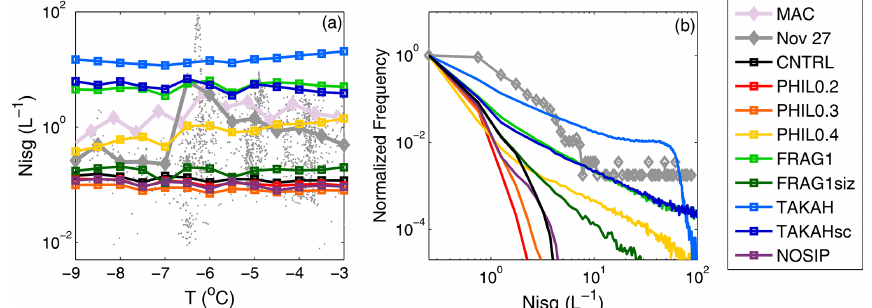
Figure 2. (a) Mean ice number concentrations (cloud ice + snow + graupel; N isg ) as a function of temperature for the whole MAC cam- paign (pink), our case study (gray) and the eight model simulations. Gray dots indicate point observations. (b) Relative frequency distribu- tion of N isg , binned in 0.5L − 1 intervals and scaled with maximum frequency. Ice properties are calculated for particles > 80µm and for N isg > 0 . 005L − 1 within the lowest